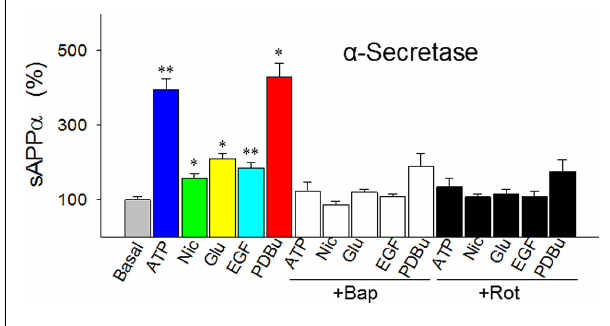
FIGURE 3 | Responses of α -secretase activity (measured as sAPP α levels) to five agents that represent the five best known metabolic/signal pathways regulating α -secretase (energy-, cholinergic, glutamatergic, ERK/MAPK- and PKC-related pathways, respectively). The agents were tested in the absence or presence of intracellular Ca 2 + chelator BAPTA-AM (Bap, 10 nM) or energy metabolism inhibitor rotenone (Rot, 1 μ M) in cultured SH-SY5Y cells. In the experiments testing the inhibitors, the cells were preincubated with Bap or Rot for 10 min before the addition of the agents. All values are means + SEM from at least five independent experiments. * p < 0.01; ** p < 0.001, versus basal level. Nic, nicotine; Glu, glutamate; EGF, epidermal growth factor; PDBu, phorbol 12, 13-dibutylester. Methods forWestern blotting to determine the sAPP α levels were as previously described (Chen and Fernandez,